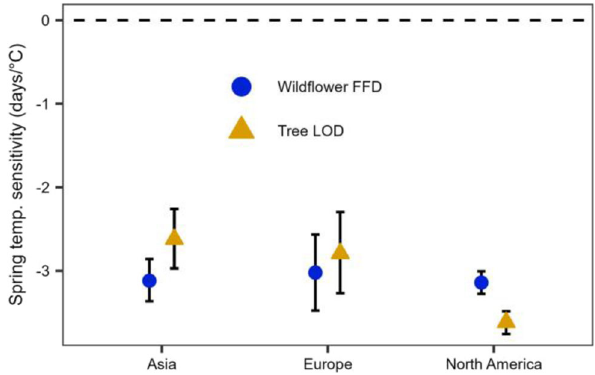
Fig. 2 | Posterior estimated means and 95% credible intervals for spring tem- perature sensitivity. Shapes represent parameter estimates for wild fl ower First Flower Date (FFD, blue circles; n =1418, 618, and 1060 for Asia, Europe, and North America, respectively) and canopy tree Leaf Out Date (LOD, yellow triangles; n =899,532,and995,forAsia,Europe,andNorthAmerica,respectively).Estimates are considered different from 0 if credible intervals do not overlap the dashed 0 line and are considered different from each other if credible intervals do not